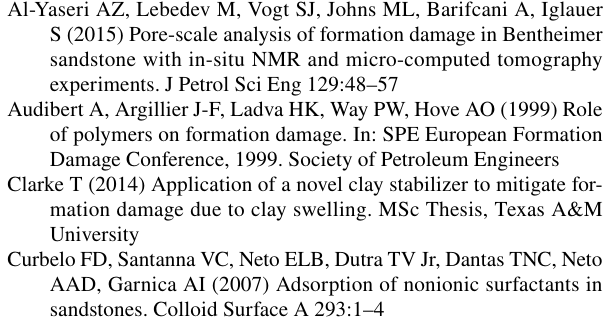
Fig. 13 Cross plot of rock-typing factor before and after